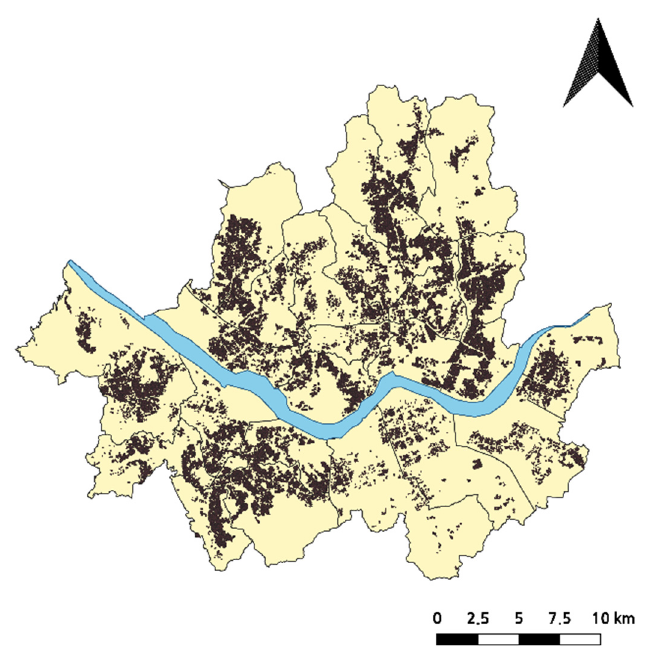
Figure 12. Spatial distribution of detached house transactions in Seoul, 2006–2018.